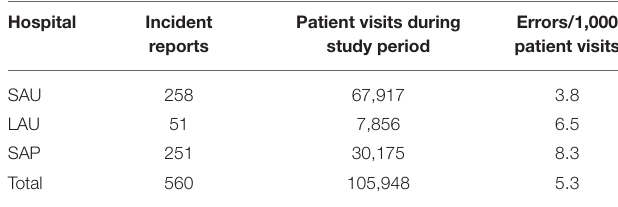
TABLE 3 | Numbers of incident reports, patient visits, and errors per 1,000 patient visits for each hospital (see Figure 1 for hospital abbreviations).